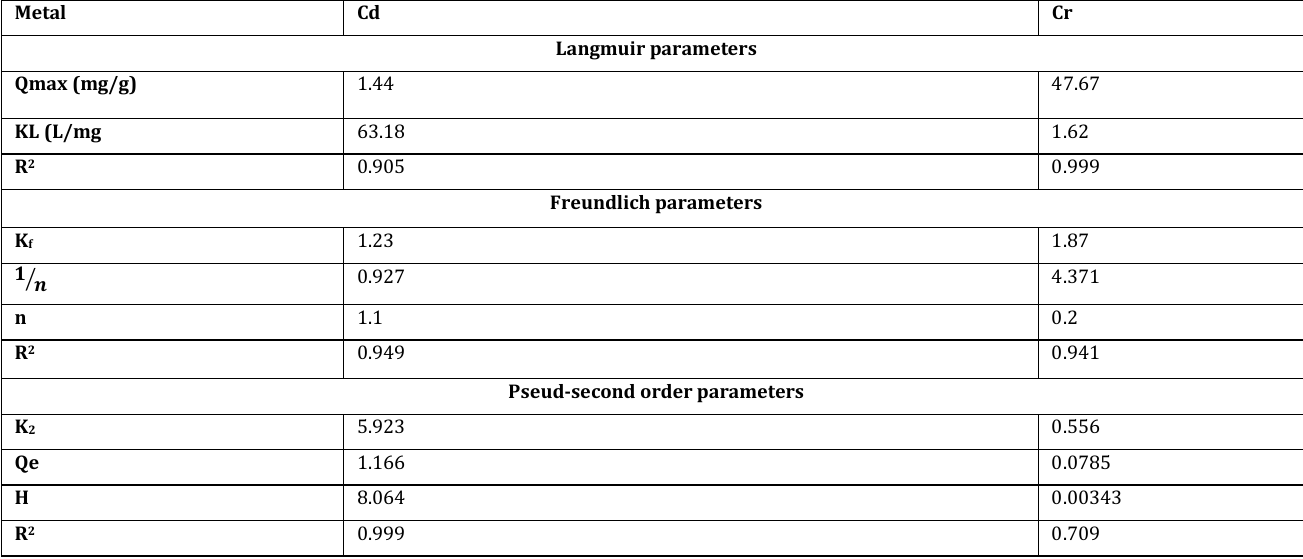
Table 9: Adsorption isotherm constants for adsorption of Cd (II) and Cr (VI) on unripe banana (musa sapientun) peel